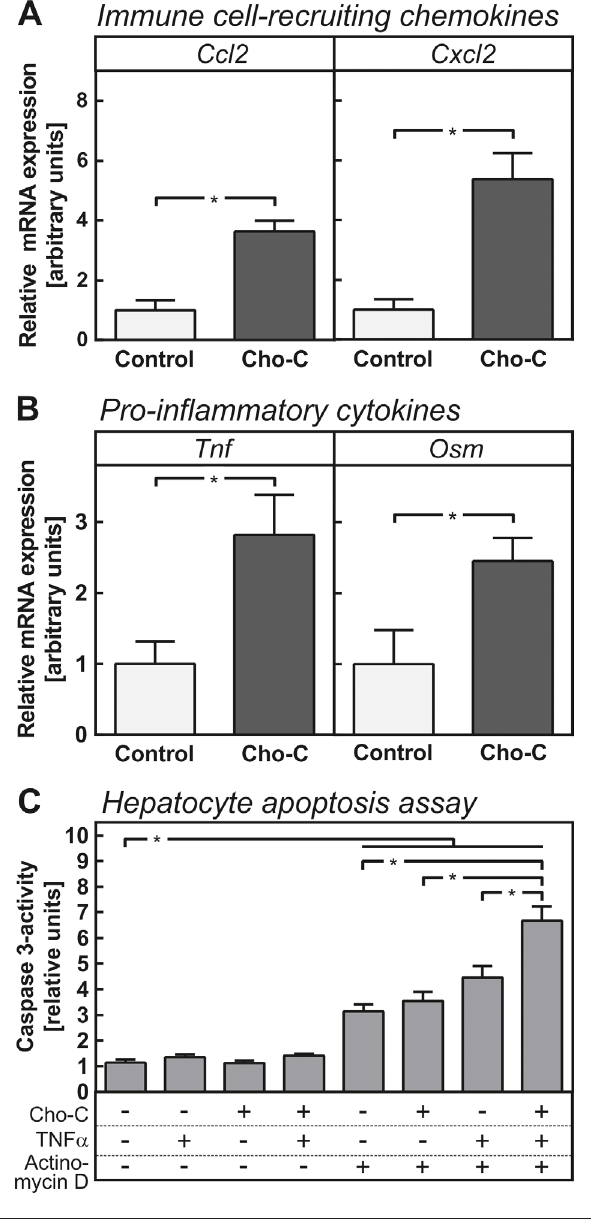
Figure 6. Cholesterol provoked a proinflammatory response in Kupffer cells and increased apoptosis in hepatocytes. (A,B) Primary mouse Kupffer cells were stimulated with 1